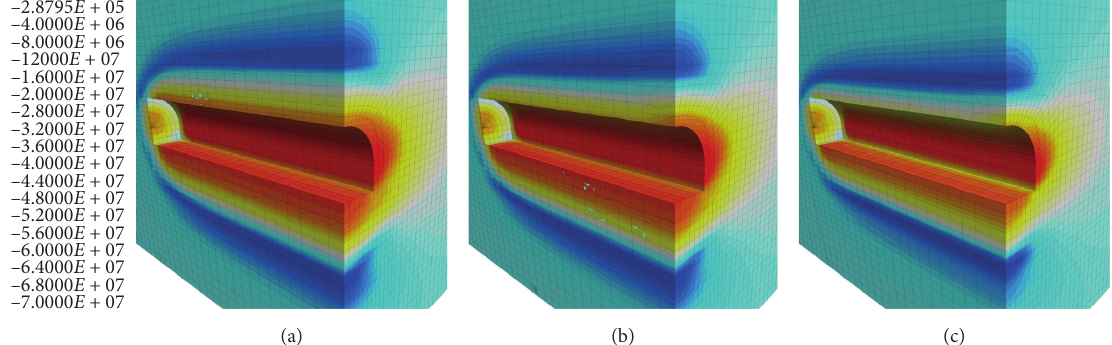
Figure 13: XX-stress. (a) Unsupported. (b) Primary support. (c) Secondary support.